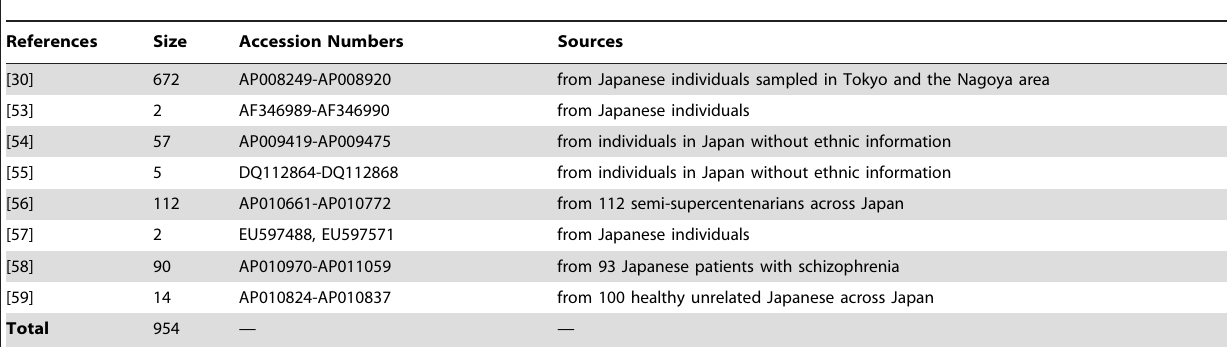
Table 1. General information for Japanese mtDNAs used in this